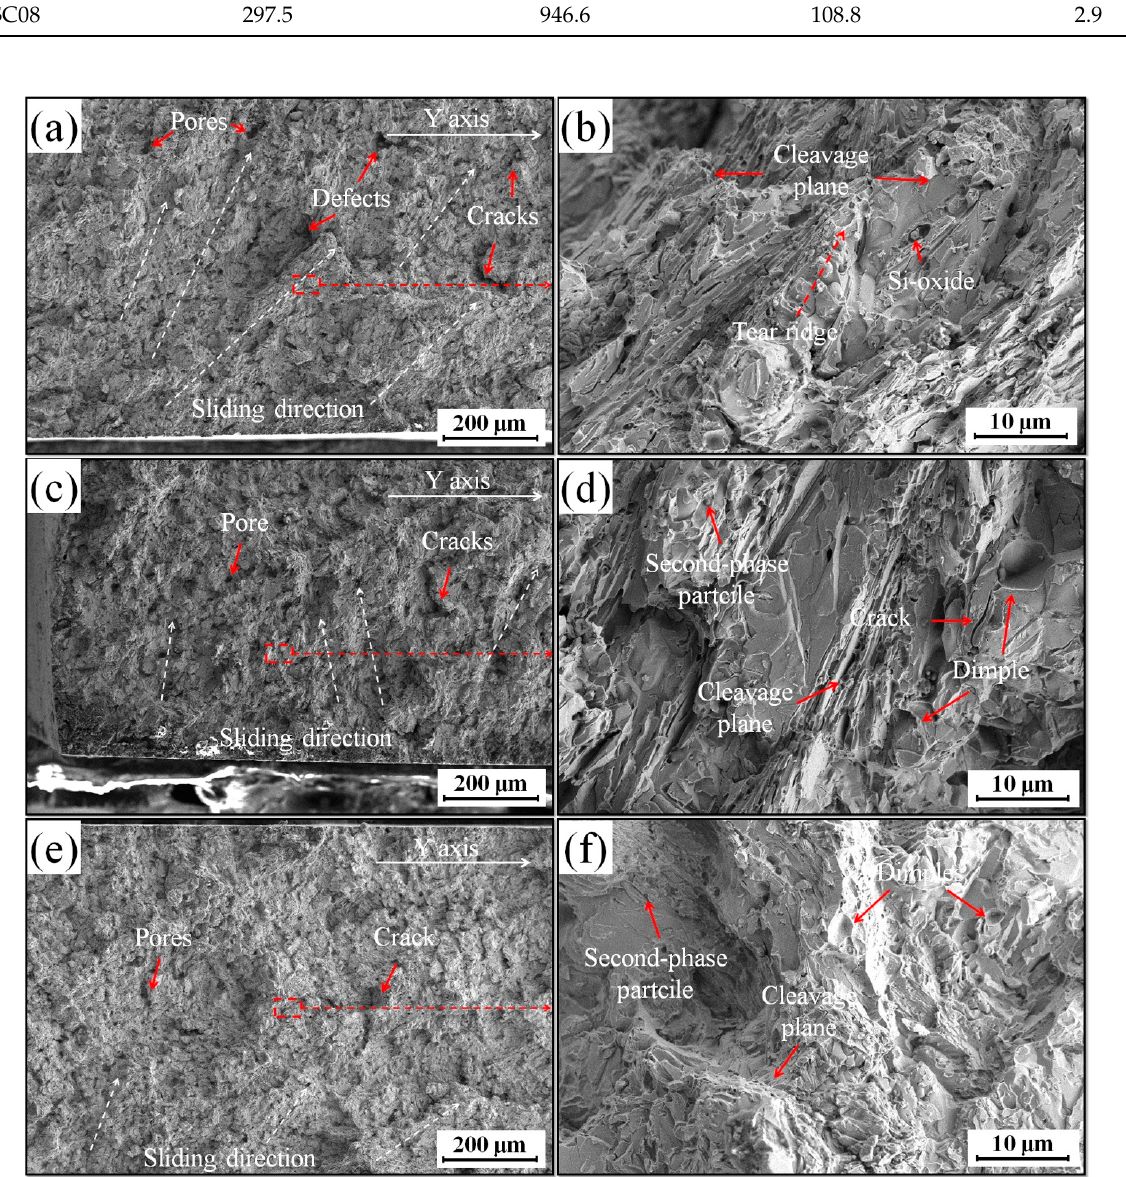
Figure 7. SEM morphology of fracture of the tensile specimen of the coating samples: ( a ) HSC0, ( b ) Enlarged image of ( a ), ( c ) HSC04, ( d ) Enlarged image of ( c ), ( e ) HSC08, ( f ) Enlarged image of ( e ).